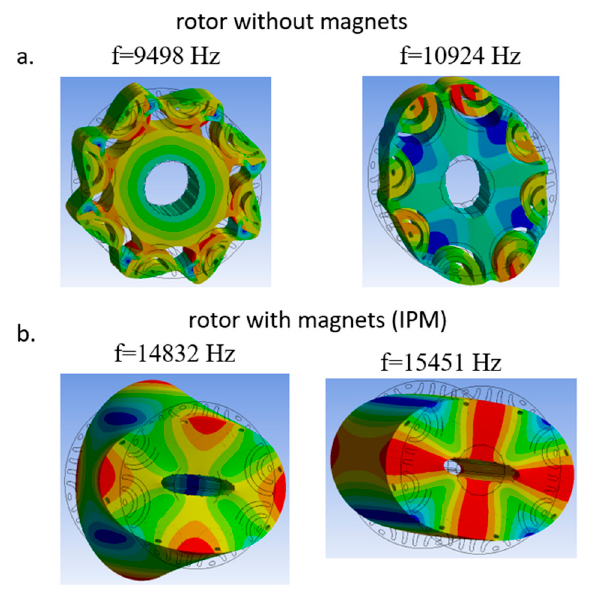
Figure 9. Results of the numerical modal analysis simulations performed for: ( a ) rotor without magnets and ( b ) rotor with magnets - IPM rotor. The deflections are indicated from minimum (blue color) to maximum (red color).